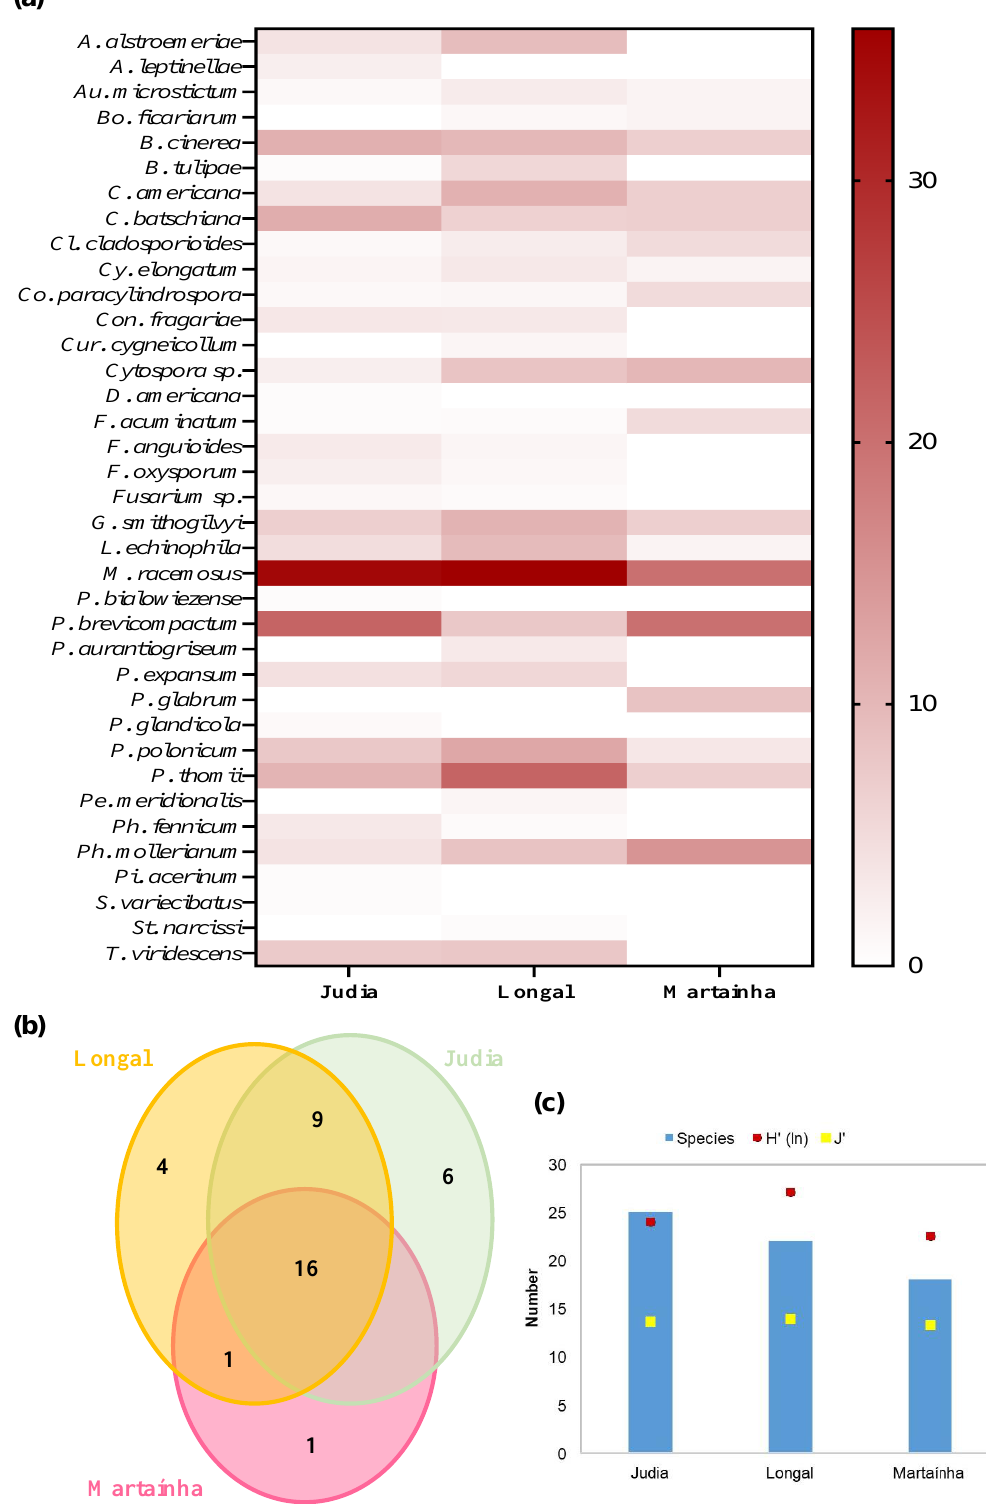
Figure 7. ( a ) Heat map of the frequency of the fungal species (in percentage of analyzed chestnuts), obtained for each variety (Judia, Longal and Marta í nha); ( b ) Venn diagram showing the unique and shared number of species in the 3 varieties; ( c ) total number of species and Shannon–Wiener, H’, and Pielou, J’, indexes for the common processing stages (P6, P7 and